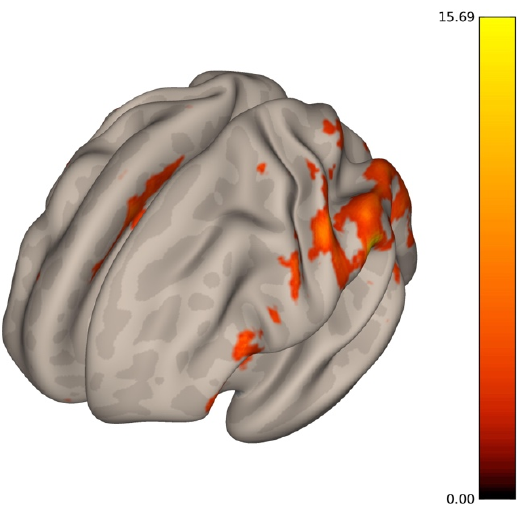
Figure 1. 3D brain surface with color map overlay reflecting the spontaneous low-frequency BOLD signal fluctuation which implies activation of distinct patterns of cerebral areas during the resting state underlying the cerebral